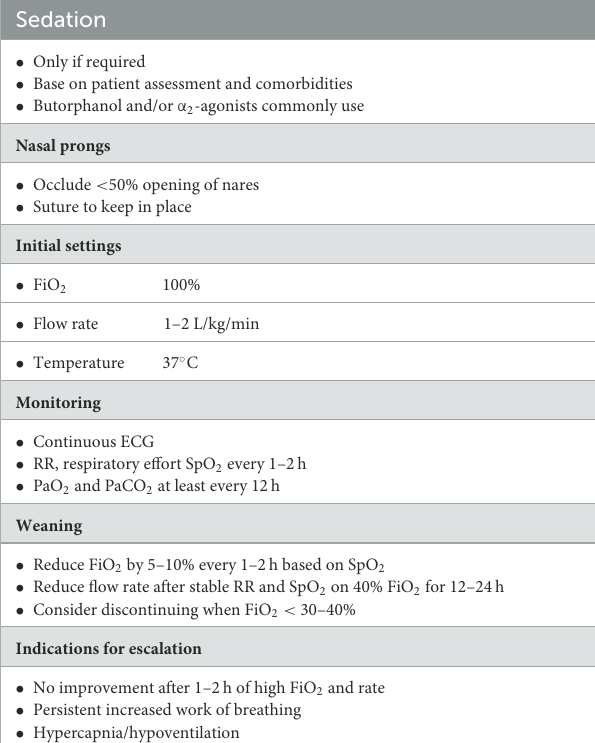
TABLE 2 A quick guide to HFNOT set up in veterinary patients.